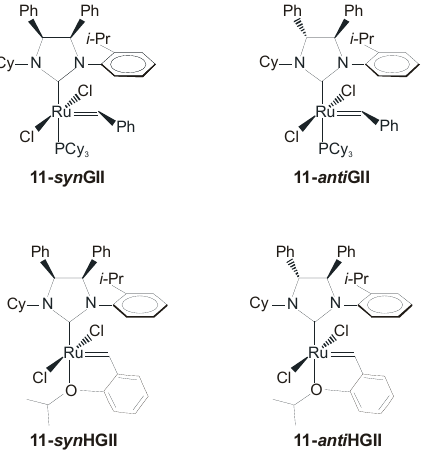
Figure 10. Catalysts with unsymmetrical NHCs and syn or anti phenyl substituted backbone.